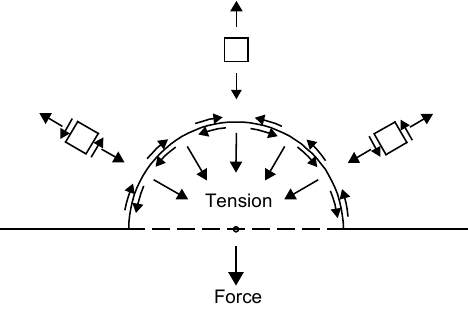
Figure 3. Stress flow on interface between spalled concrete and slab.